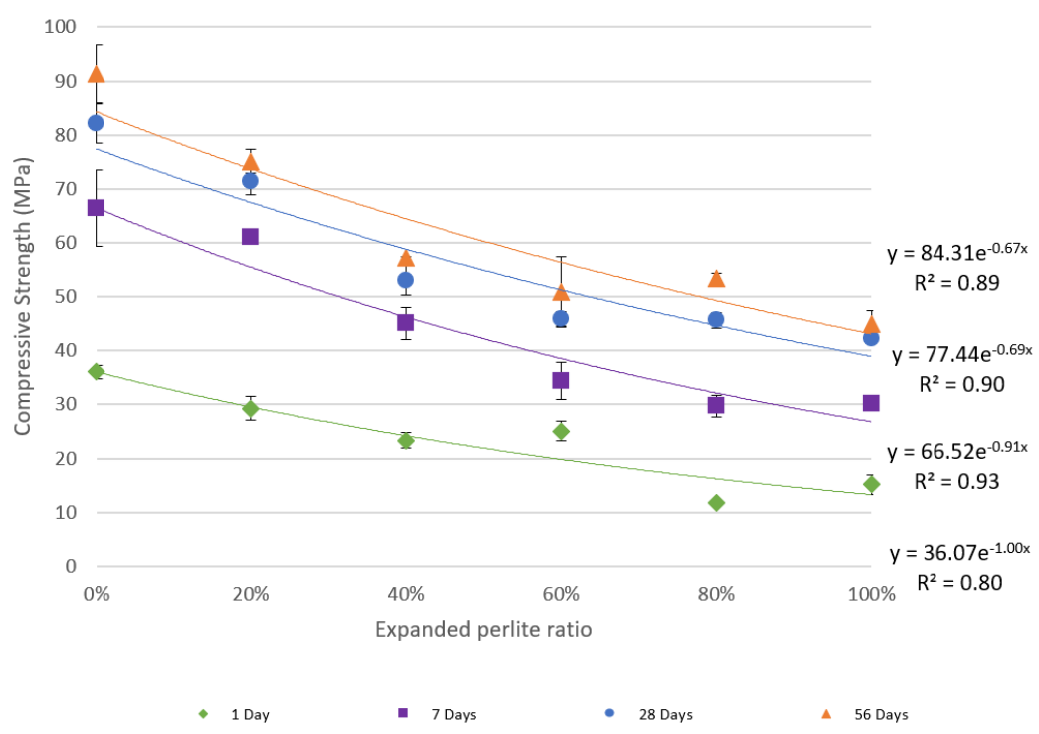
ff ects of EP incorporation on the compressive strength of the Figure 6. Effects of EP incorporation on the compressive strength of the cement. Figure 6. E